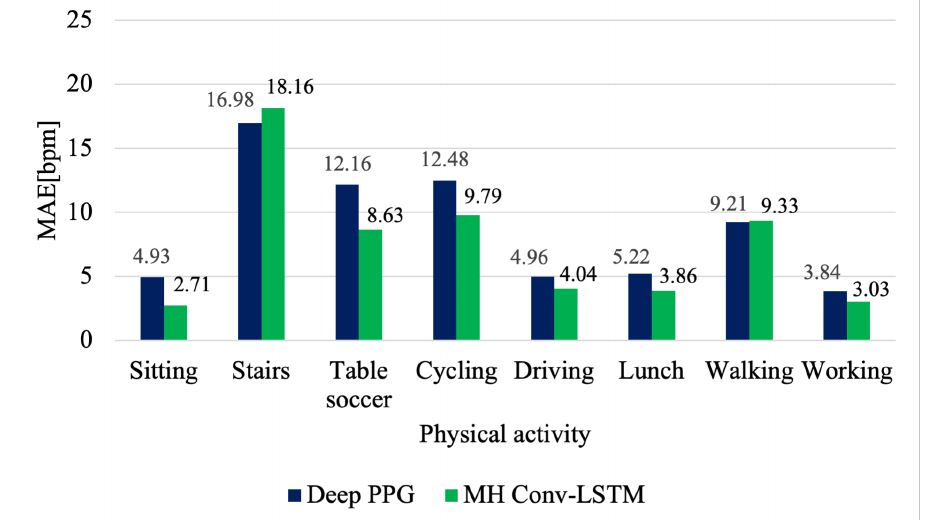
Figure 4. Comparison of the average activity scores for Deep PPG and MH Conv-LSTM DeepPPG. Performance of Deep PPG taken from [13], Table